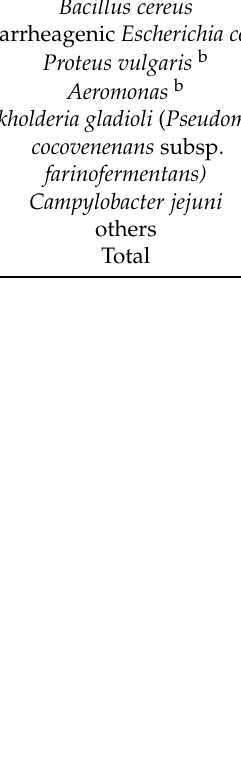
Table 3. Setting distribution of outbreaks of bacterial FBDOs in Zhejiang Province from 2010 to